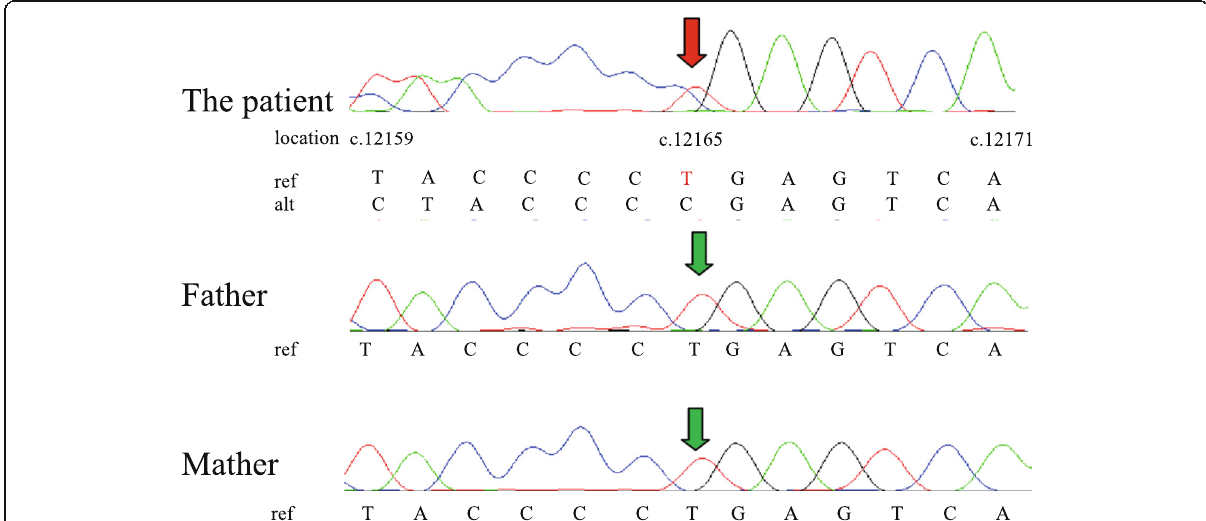
Fig. 3 Sanger sequencing results of the patient and her parents. The single nucleotide deletion in the patient is indicated by the red arrow. The same position in her parents is indicated by the green arrow. The reverse primer was used for sequencing, and the mutation was a reverse- complement reading. The “ c. ” indicates the position in the transcript (NM_003482.3). The red letter “ T ” in the ref. line of the patient indicates the deletion of a